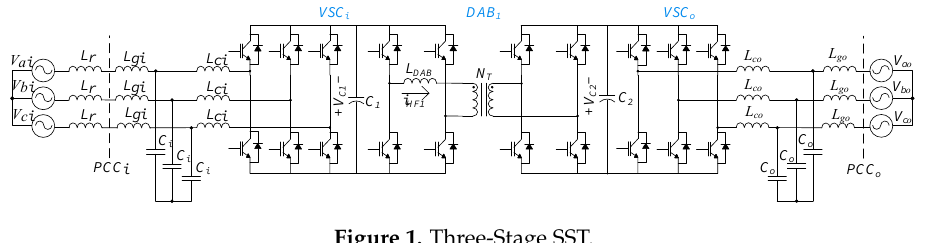
Figure 1. Three-Stage